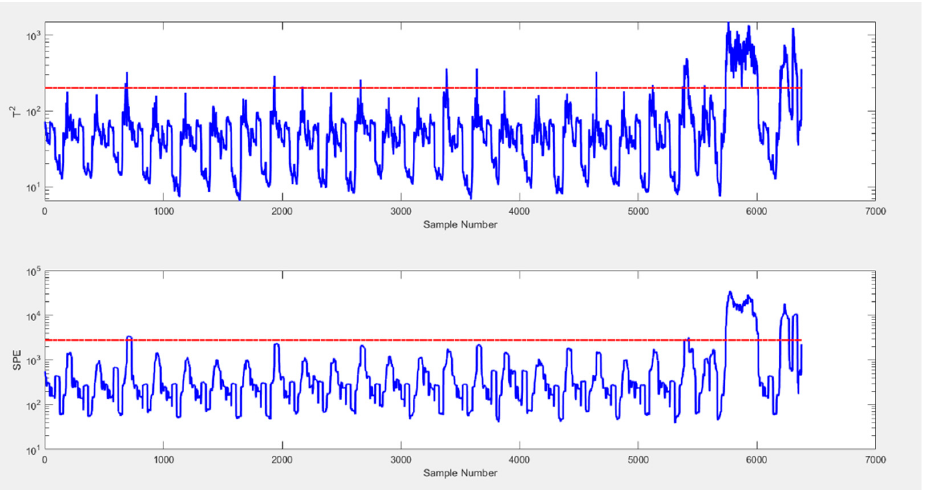
Figure 8. T 2 and Q for period C Figure 8. (cid:1846) 2 and Q for period C .